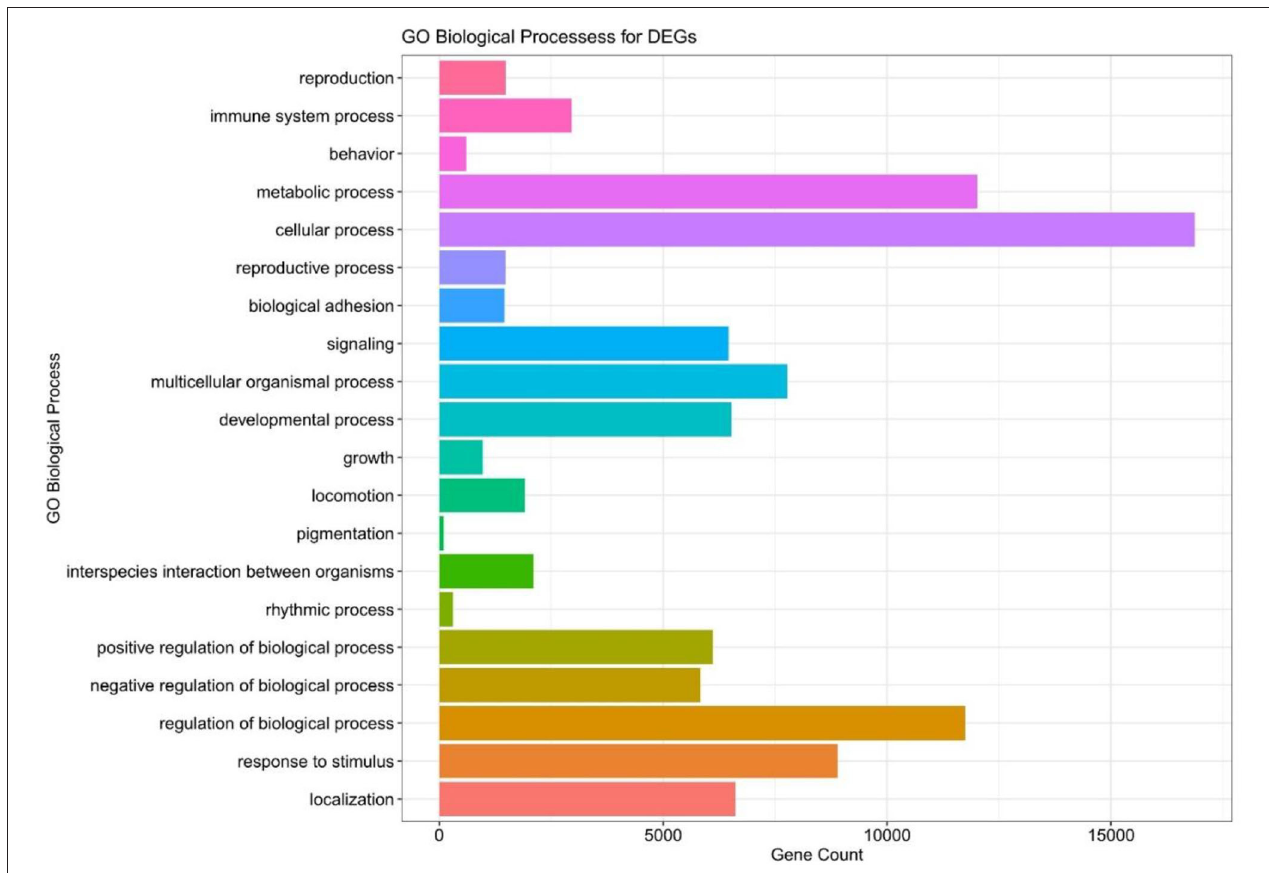
FIGURE 5 | The GO biological pathway analysis of the DEGs in all the compared groups.